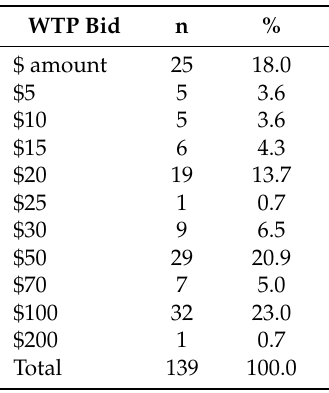
Table 4. Reported annual willingness to pay (WTP) for the provision and access to parks in Victoria, Australia. All dollar values listed are in